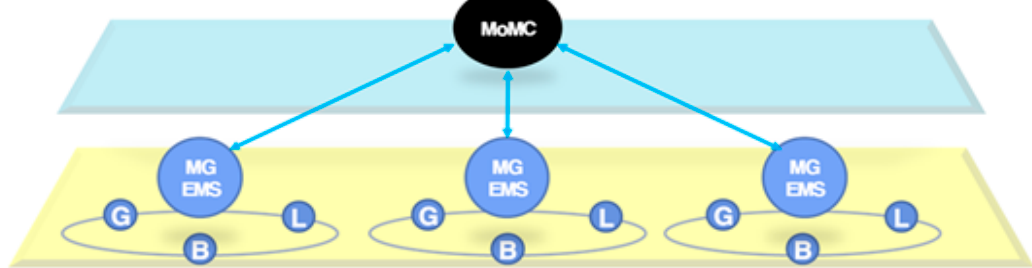
Figure 2. Hierarchical structure diagram of multiple microgrid.